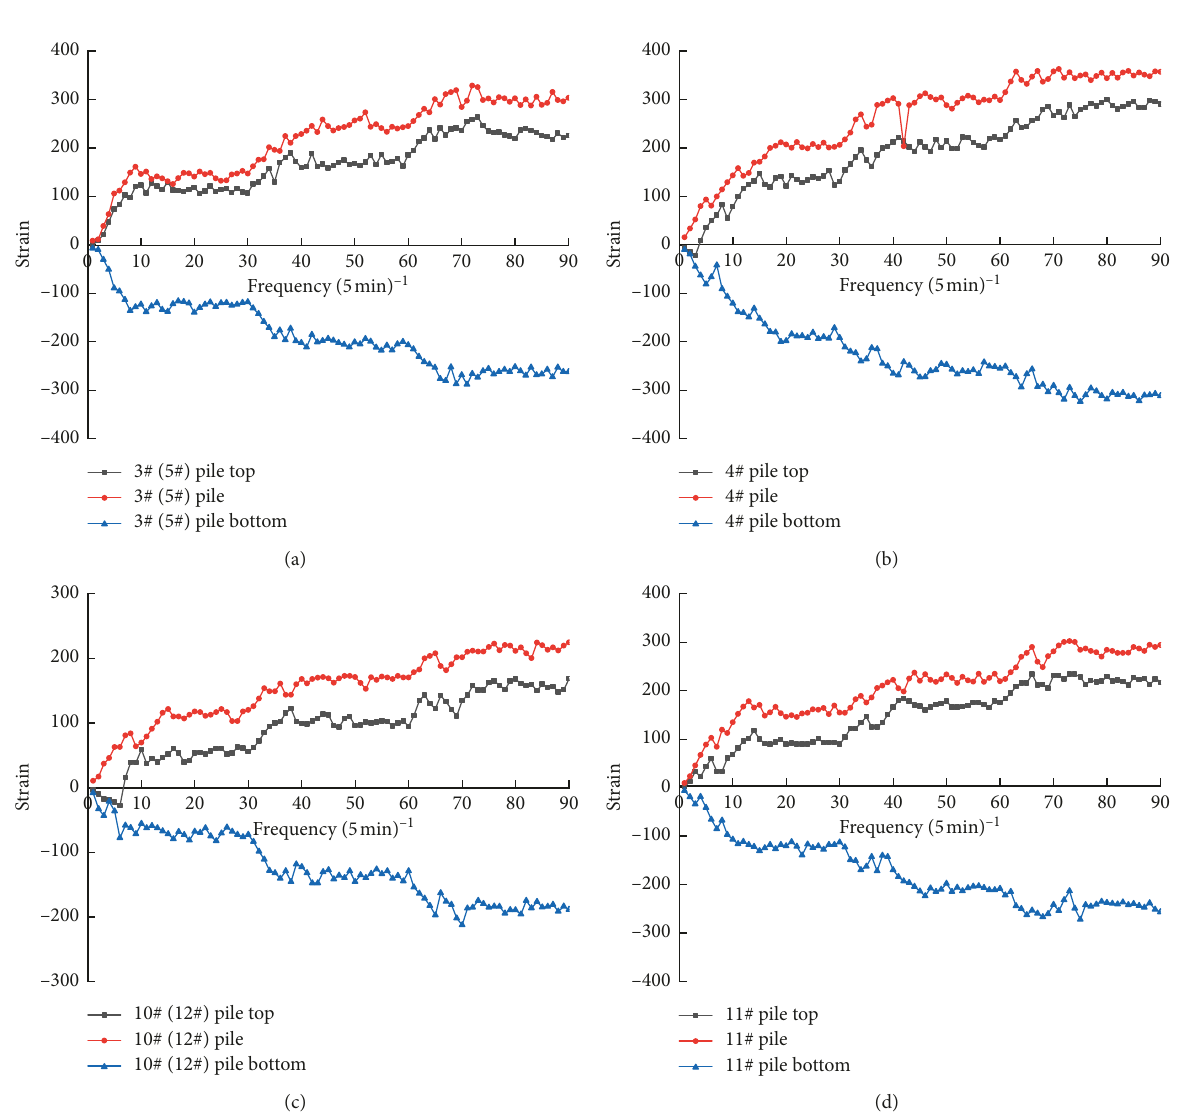
Figure 12: Pile strain time curves. (a) Pile 3. (b) Pile 4. (c) Pile 10. (d) Pile